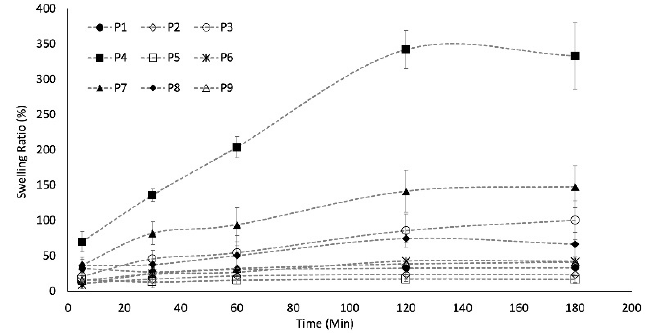
Figure 4. Swelling profiles of the